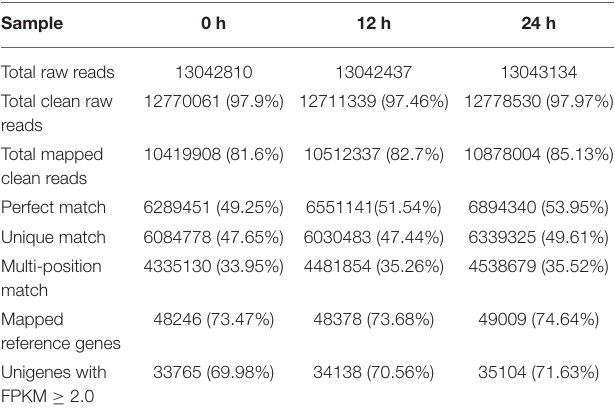
TABLE 1 | Alignment of Illumina HiSeq 2000 reads onto the R. glutinosa reference